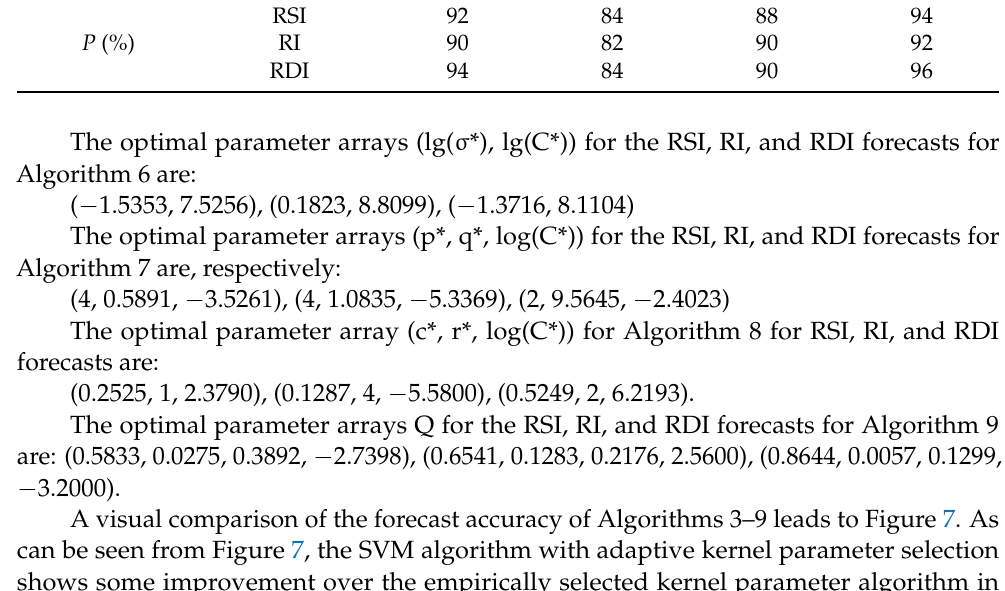
Algorithm 7: SVM model with adaptive selection of polynomial kernel parameters. The polynomial kernel parameters are p,q and penalty factor C; their initial values are Algorithm 8: SVM model with adaptive selection of Sigmoid kernel parameters. The Sigmoid kernel parameters are c, r, and penalty factor C; their initial values are chosen as Algorithm 9: SVM model with adaptive composite kernel species. The parameters of this model are ρ 1 , ρ 2 , ρ 3 and penalty factor c; their initial values are chosen as ( ρ 10 , ρ 20 , ρ 30 ,